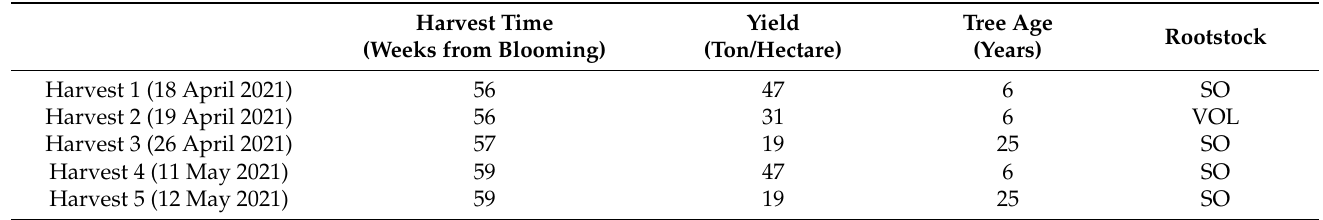
Table 1. Harvest times, yields, tree age, and rootstocks of the ‘Valencia’ orchards used for the current